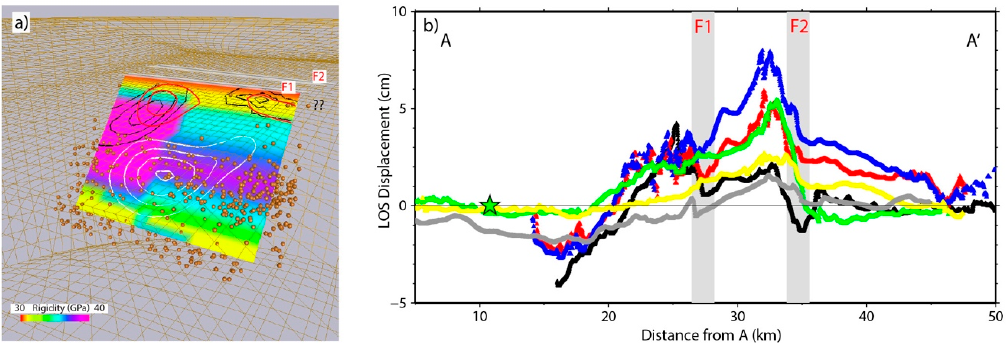
Figure 11. Coseismic and post-seismic results: ( a ) 3D view of the Van earthquake fault from the NW. Coseismic slip (white lines, contour every 2 m) and the post-seismic slip (red and black lines are three and 17 days after the mainshock, respectively, contour every 10 cm) superimposed on the rigidity heterogeneities of the fault plane within the FE model. Aftershocks hypocenters within 4 km from the fault are shown by ochre spheres; ( b ) AA’ profile (see Figure 5a) across the traces of the main fault (F1) and the splay fault (F2). The colors are: CSK2, black; CSK3, blue; TSX1, grey; TSX2, yellow; TSX3, green; and the difference between CSK3 and TSX2, red. The green star is the Van earthquake epicenter.